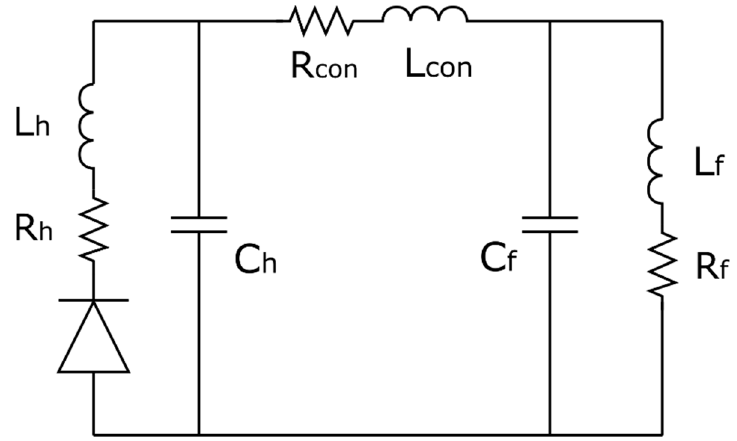
Figure A1. Equivalent simplified circuit of the fault transient.